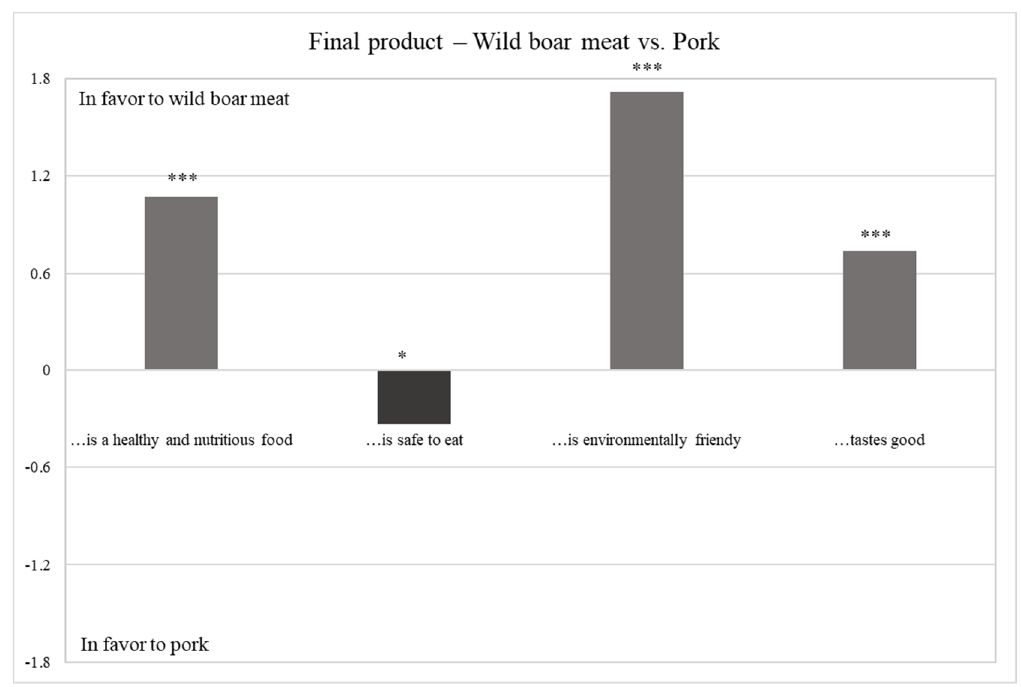
Figure 4. Difference between perceptions towards wild boar meat vs. pork. *** Sign. < 0.001; ** Sign. < 0.010; * Sign. < 0.050 n.s. not significant .